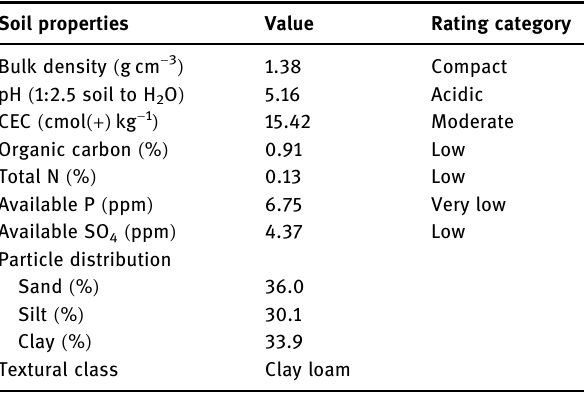
Table 1: Physicochemical properties of the experimental soil before starting the experiment